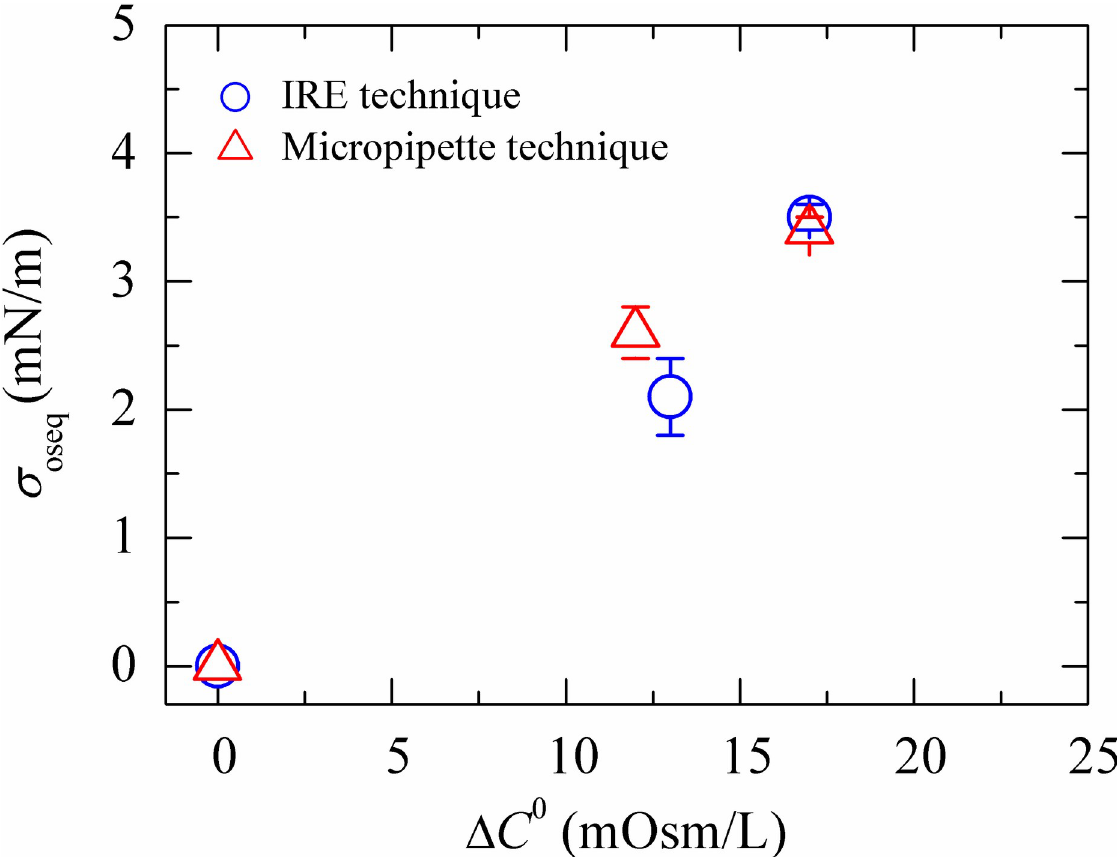
Fig 5. Comparison of the experimentally estimated membrane tension for DOPG/DOPC (40/60)-GUVs using the IRE technique and the micropipette technique. The data on the membrane tension using the micropipette technique was taken from [11].